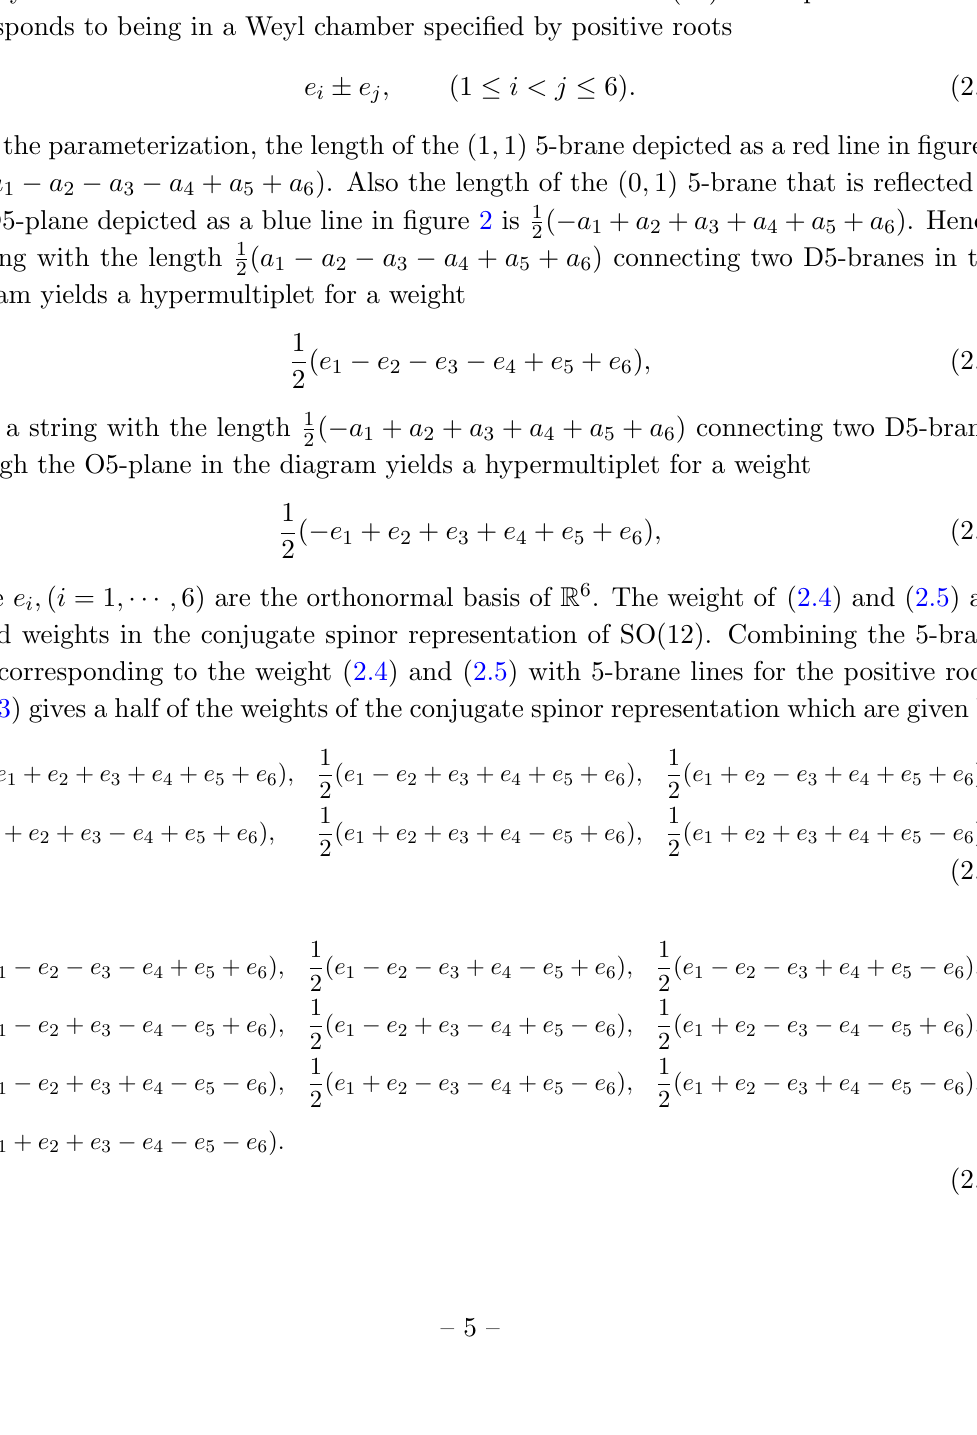
; a ; a ; a ; a ; a as in (cid:12)gure 2 1 2 3 4 5 6